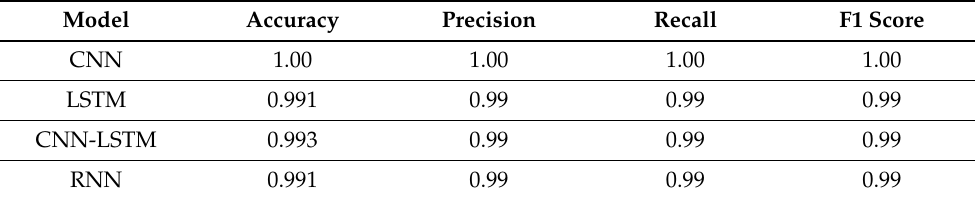
Table 12. Performance of deep learning models using multi-features with 25 k samples.